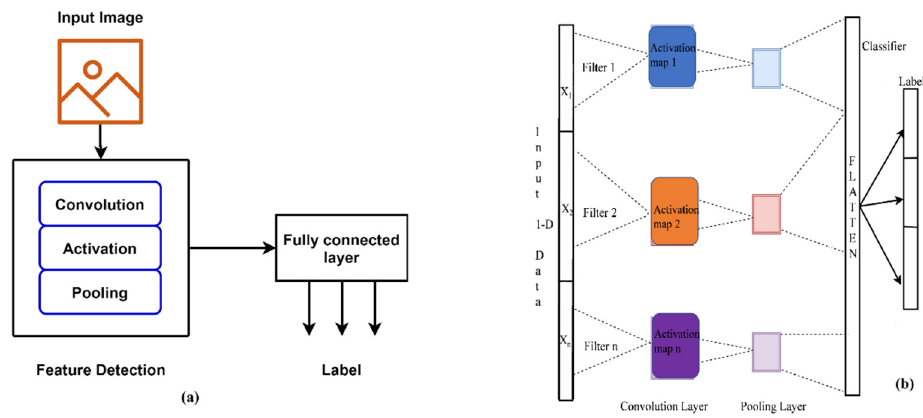
Figure 4. Common architecture of ( a ) 2-D CNN and ( b ) 1-D CNN.